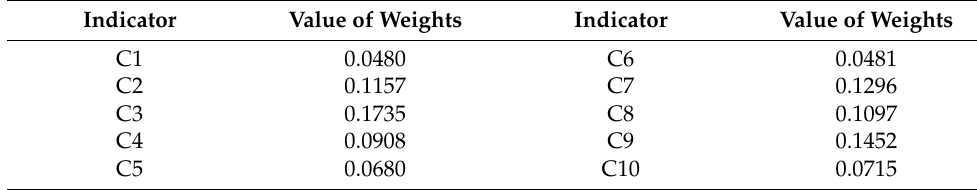
Table 2. Weights of ten